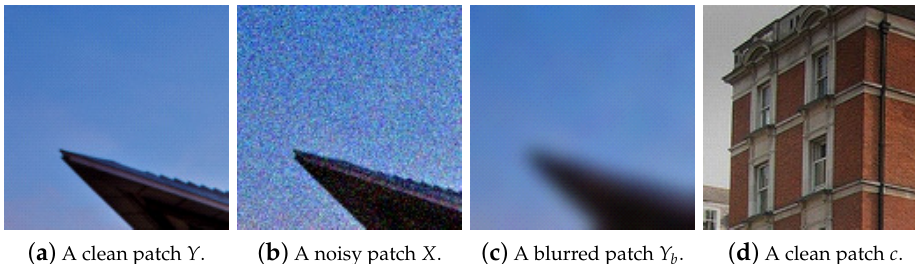
Figure 2. Example data: ( a ) a clean patch to generate noisy and blurred patches; ( b ) a noisy patch with Gaussian noise; ( c ) a blurred patch by a Gaussian filter with kernel size of 31; ( d ) a clean patch collected from the